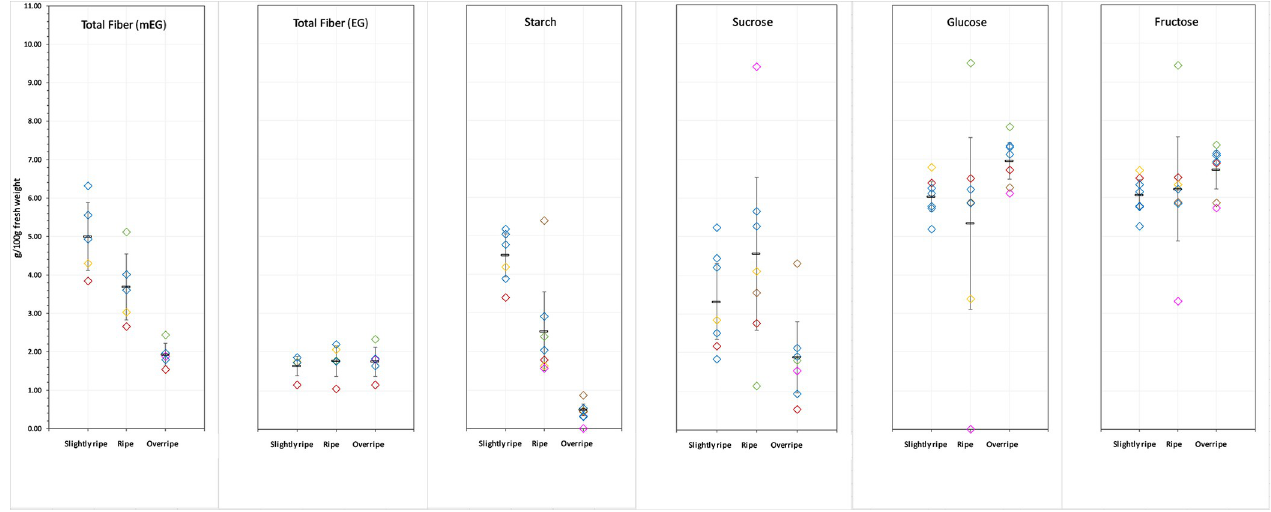
Fig 4. Dietary fiber, starch, and sugars in retail samples of bananas of the same ripeness (defined as in Fig 1). Data points in the same color are from the same sample (i.e., same hand(s) from the same lot, supplier, purchase point/time), where a portion of the bananas were allowed to ripen further, and the red symbols ( � ) denote the ripening study samples. EG = enzymatic-gravimetric method (AOAC 991.43) [14]; mEG = modified enzymatic-gravimetric (“McCleary”) method (AOAC 2011.25) [16]. ─ mean, with error bars showing two times the standard error. Maltose was < 0.5 g/100g in all